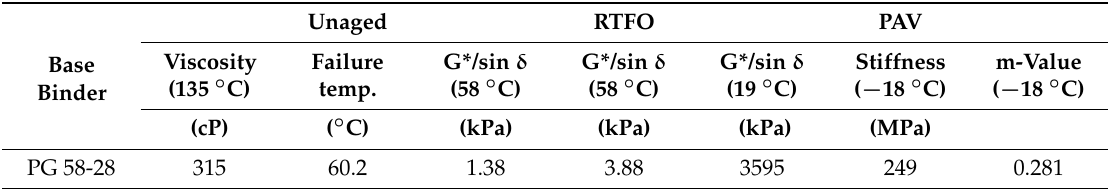
Table 1. Rheological properties of performance grade (PG) 58-28